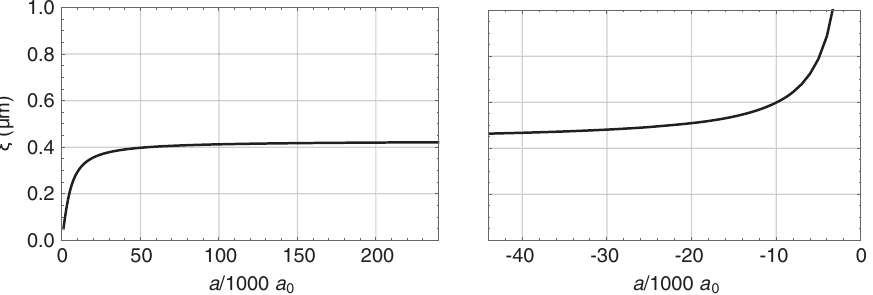
FIG. 12. Pair size ξ as a function of the scattering length. Linear densities ρ 0 from 1 to 3 atoms = μ m correspond to interparticle spacings from 1 to about 0 . 3 μ m, which is of the order of the pair size. For higher densities and/or weaker interactions the pairs become larger than the interparticle separation and the mapping to a super-Tonks-Girardeau gas fails. Left and right panels correspond to positive and negative scattering lengths a